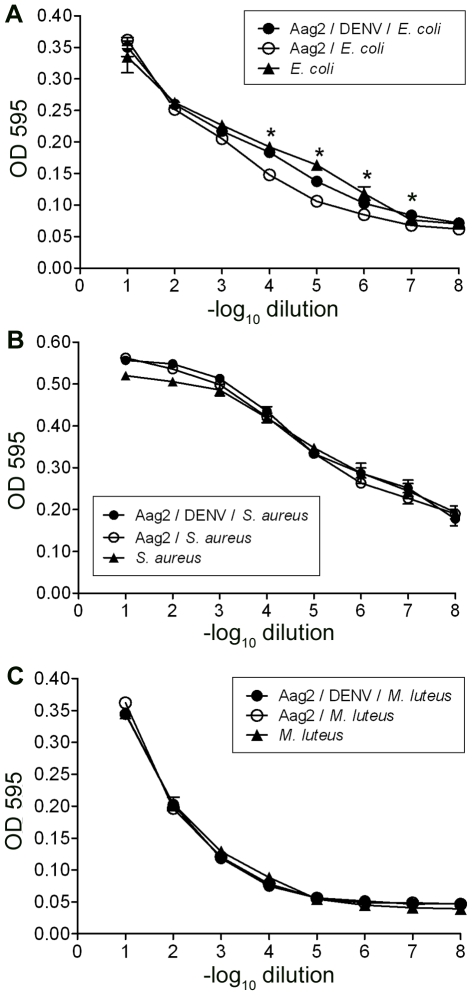
DENV-infected cells are less able to inhibit the growth of Gram-negative bacteria in co-culture.Eight 10-fold dilutions of Gram-positive or Gram-negative bacteria were inoculated into the cell culture medium in 96-well plates containing DENV- or mock-infected Aag2 cells, or cell culture medium alone. The graphs show OD595 as a measure of bacterial growth after a 12-h incubation at 28°C for (A) E. coli, (B) S. aureus, and (C) M. luteus. * represents p<0.05 in a Student's t-test comparing OD595 of bacteria incubated with DENV- and mock-infected cells. Error bars indicate the standard error of the mean; note that in many cases the error bars are obscured by the data point.